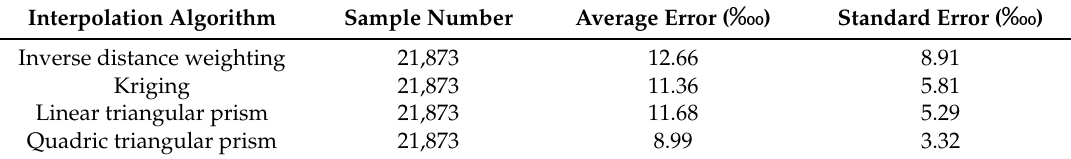
Table 1. Average error and standard error statistics.